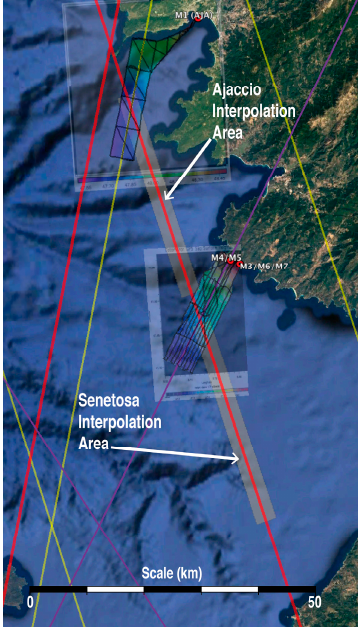
Figure 3. Map of the Sentinel-3A configuration: the shaded areas correspond to the locations where the wet tropospheric correction (radiometer and model) is interpolated.